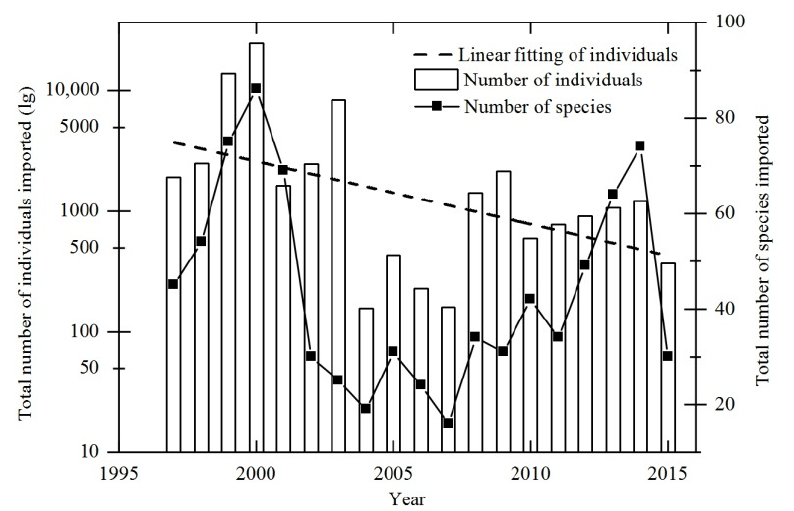
Figure 2. Annual variation in the number of imported species and individuals in China (1996–2015). Note the primary y axis scale.